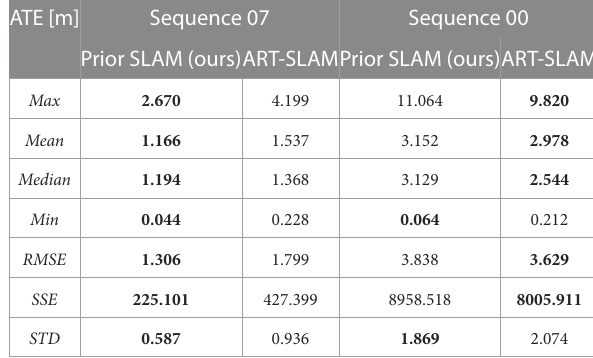
TABLE3 ATEstatisticsonSequence07andSequence00oftheKITTI odometrydatasetGeiger et al.(2012),evaluatingPriorSLAMandthe baselinewithdisabledloopdetectionandclosure.Boldnumbersrepresent